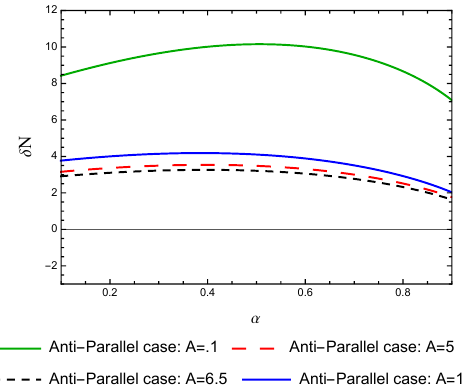
Figure 11 . Anti-parallelly accelerating detectors in (1 + 3) dimensions: δ N VS α plot for different fixed values of A with ∆ E B = 1 . a B